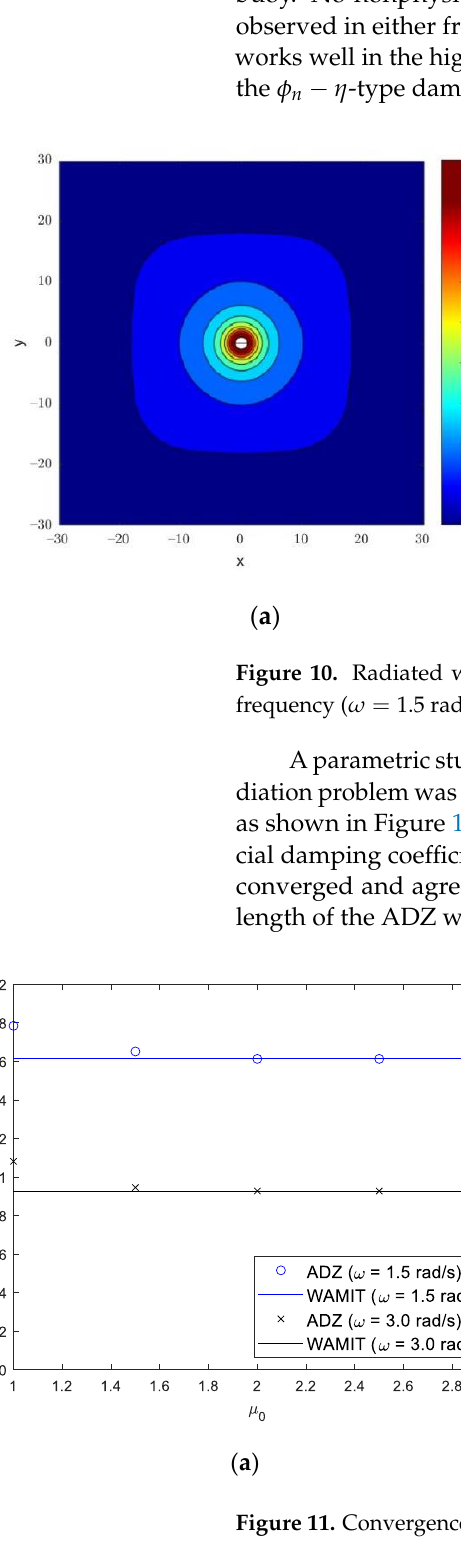
Figure 9. Comparison of the damping effects for different damping terms ( 𝜂 − 𝜙 type, 𝜙 𝑛 − 𝜂 type): ( a ) radiation wave elevation ( 𝜔 = 1.5 rad/s) ; ( b ) nondimensional heave-added mass; ( c ) nondimensional heave-damping coefficient.